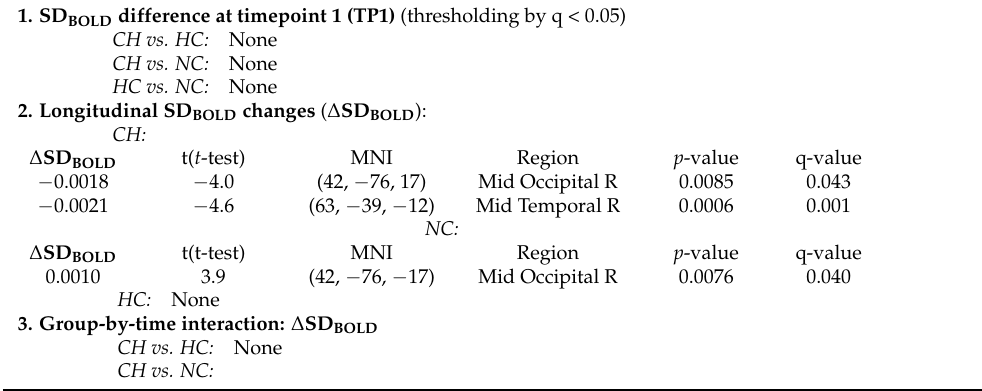
Table 2. Blood-oxygen-level-dependent signal variability in standard deviation (SD BOLD )